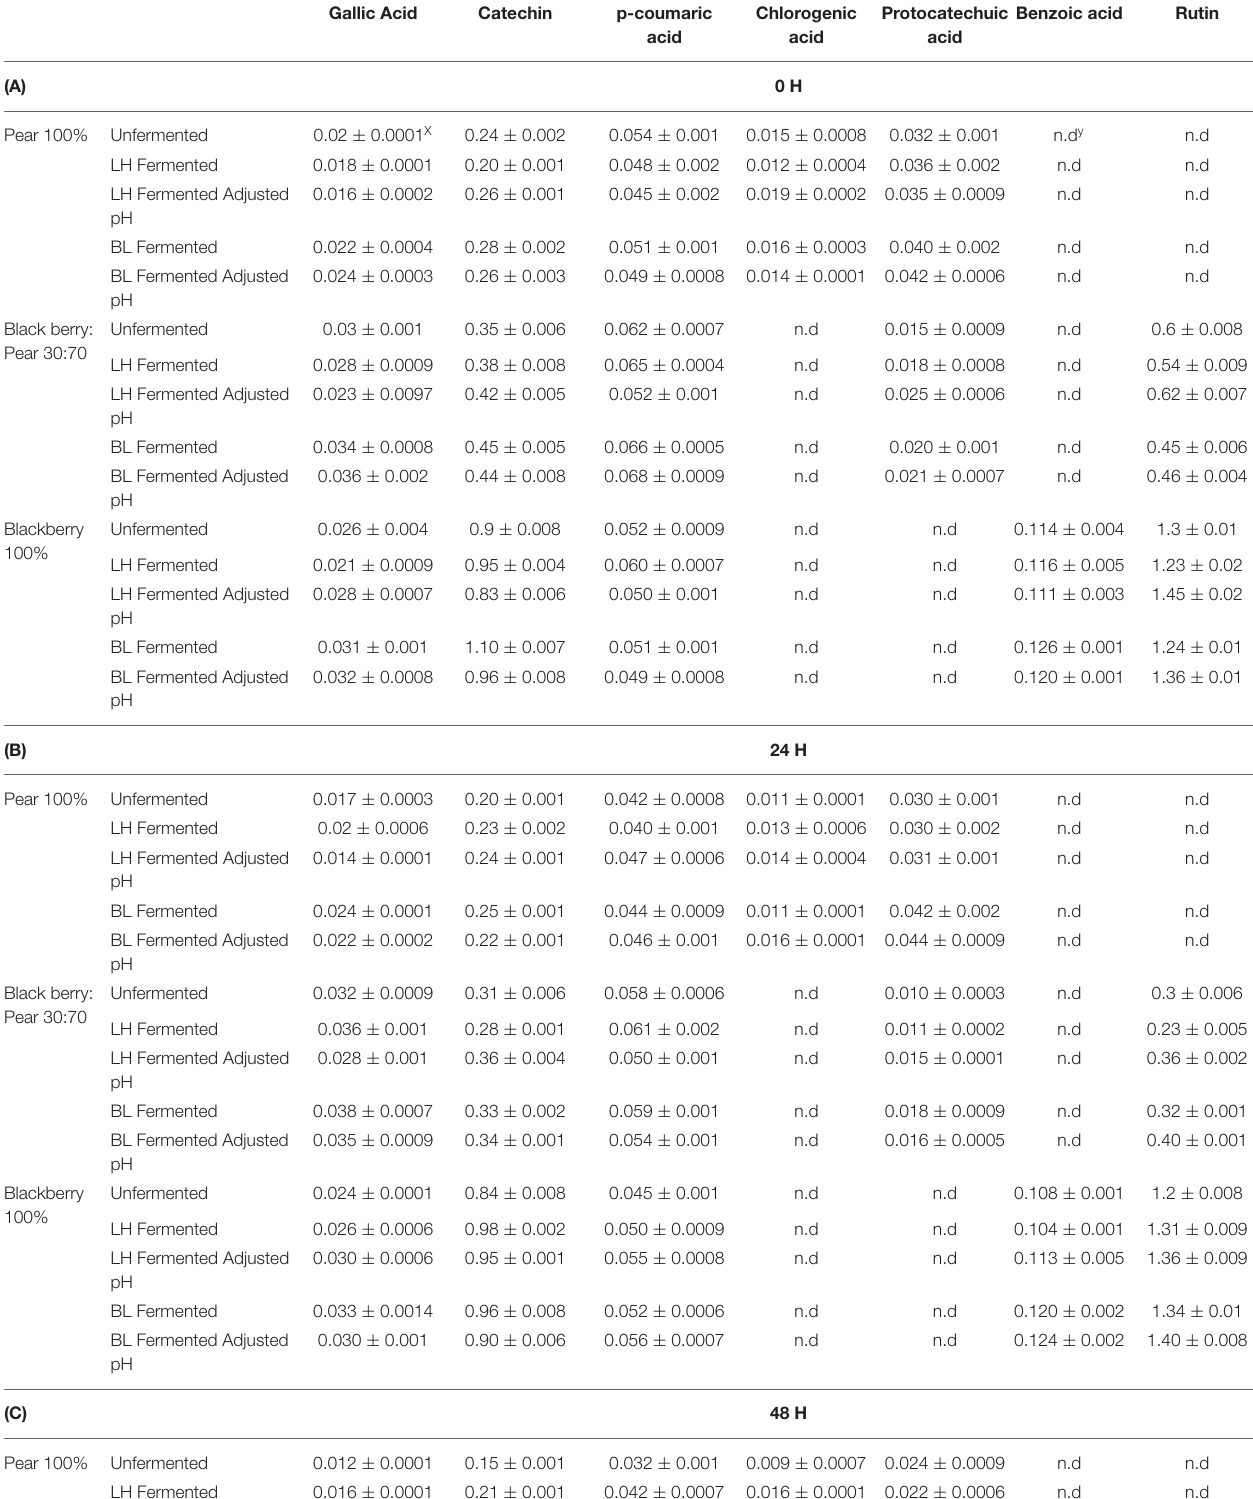
TABLE 1 | Profile and concentration of phenolic compounds ( µ g/g FW) in Bartlett pear (100%), 30:70 (blackberry: pear) combination, and Kiowa blackberry (100%) extracts following fermentation with Lactobacillus helveticus (LH) and Bifidobacterium longum (BL) at 0h (A) , 24h (B) , and 48h (C) time points. Gallic Acid Catechin p-coumaric Chlorogenic Protocatechuic Benzoic acid acid acid acid